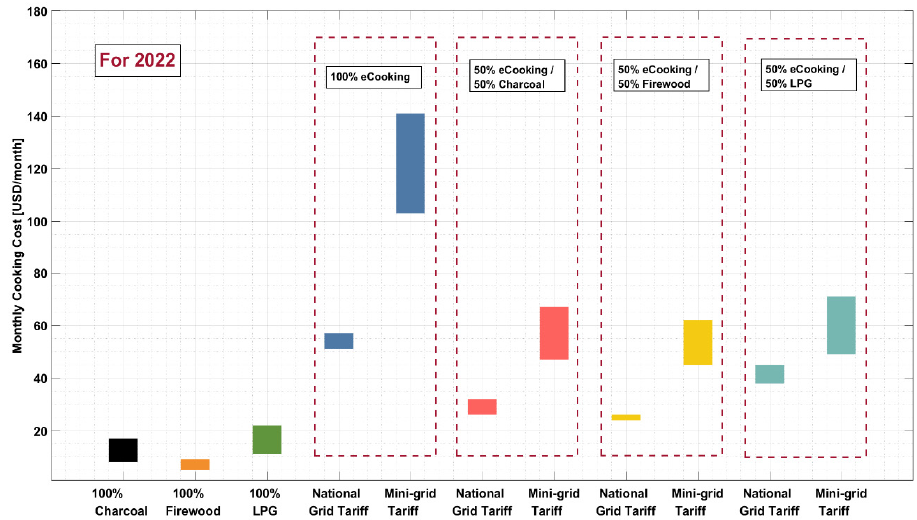
Figure 2. Monthly cooking cost of the contextualized cooking scenario under study calculated for 2022.